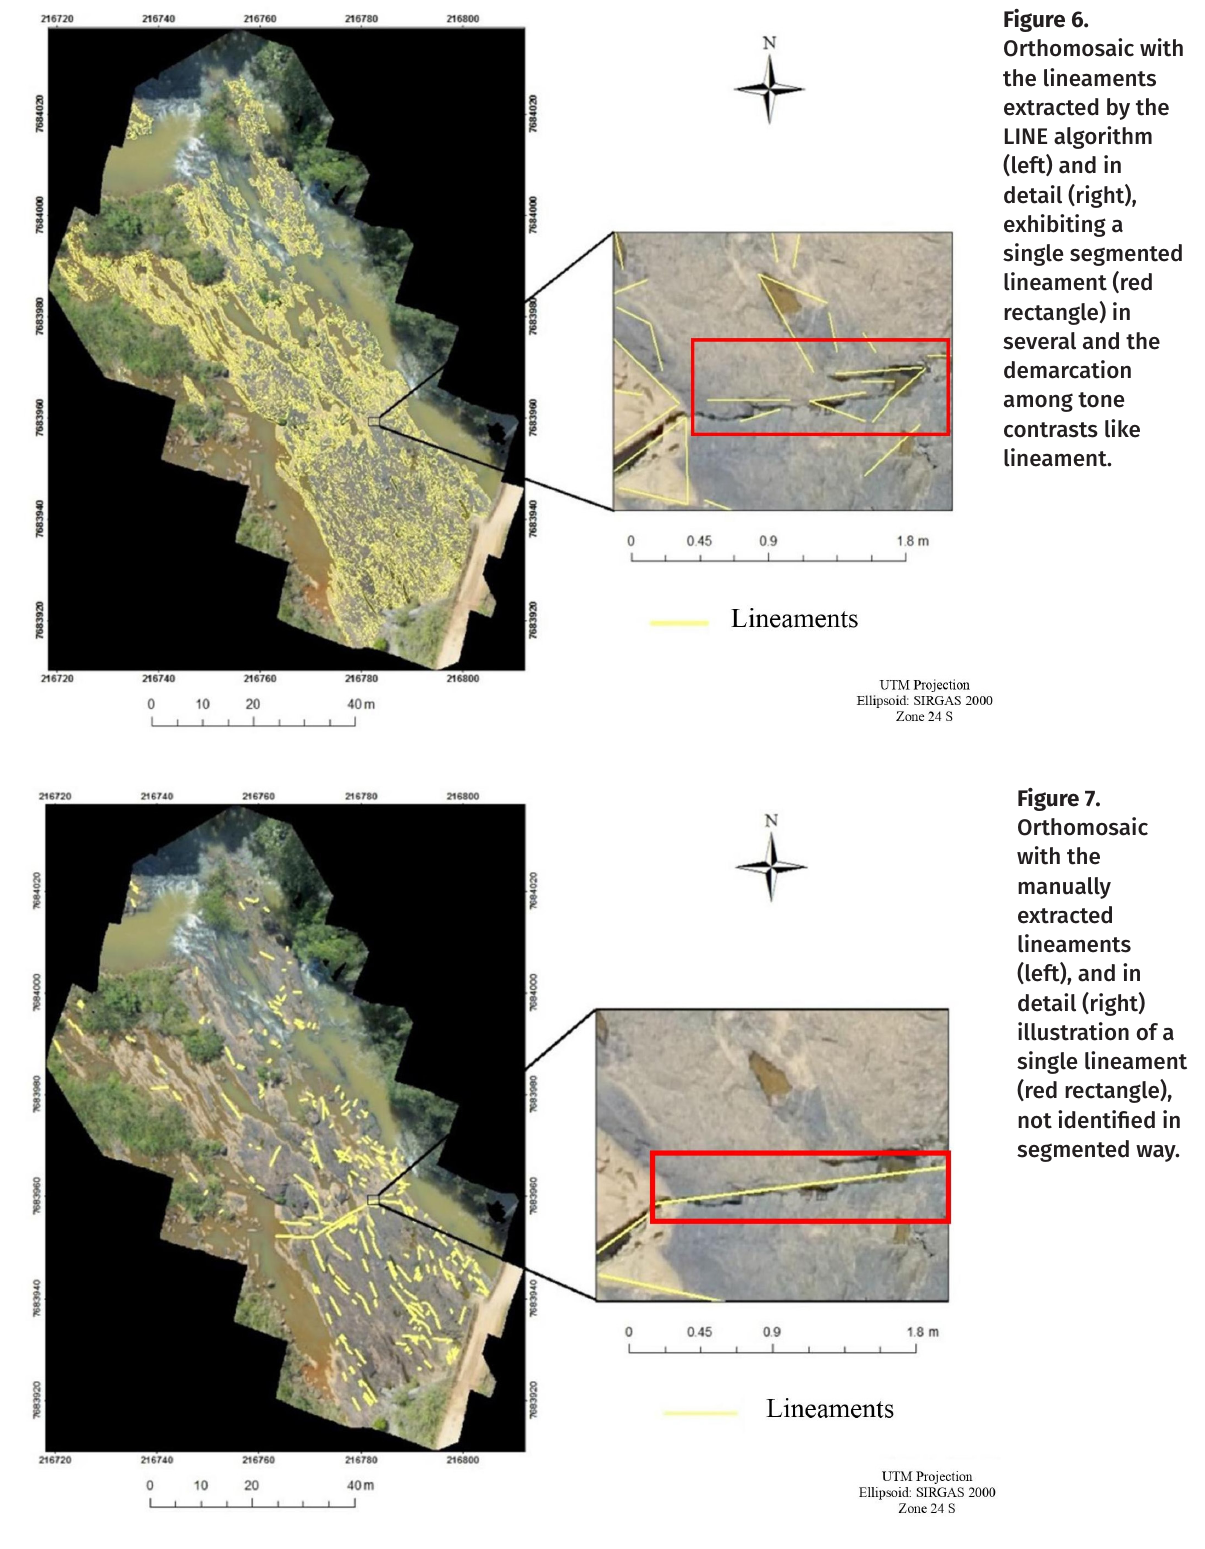
Figure 6. Orthomosaic with the lineaments extracted by the LINE algorithm (left) and in detail (right), exhibiting a single segmented lineament (red rectangle) in several and the demarcation among tone contrasts like